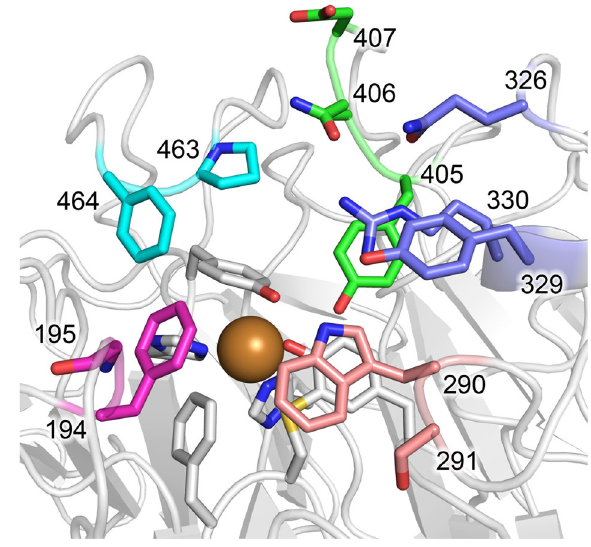
Fig. 2 Active site residues targeted for mutagenesis. Positions of active site residues targeted in the seven GOase M 3 – 5 NNK CASTing libraries, displayed on wildtype GOase crystal structure (PDBID: 1GOG). Libraries